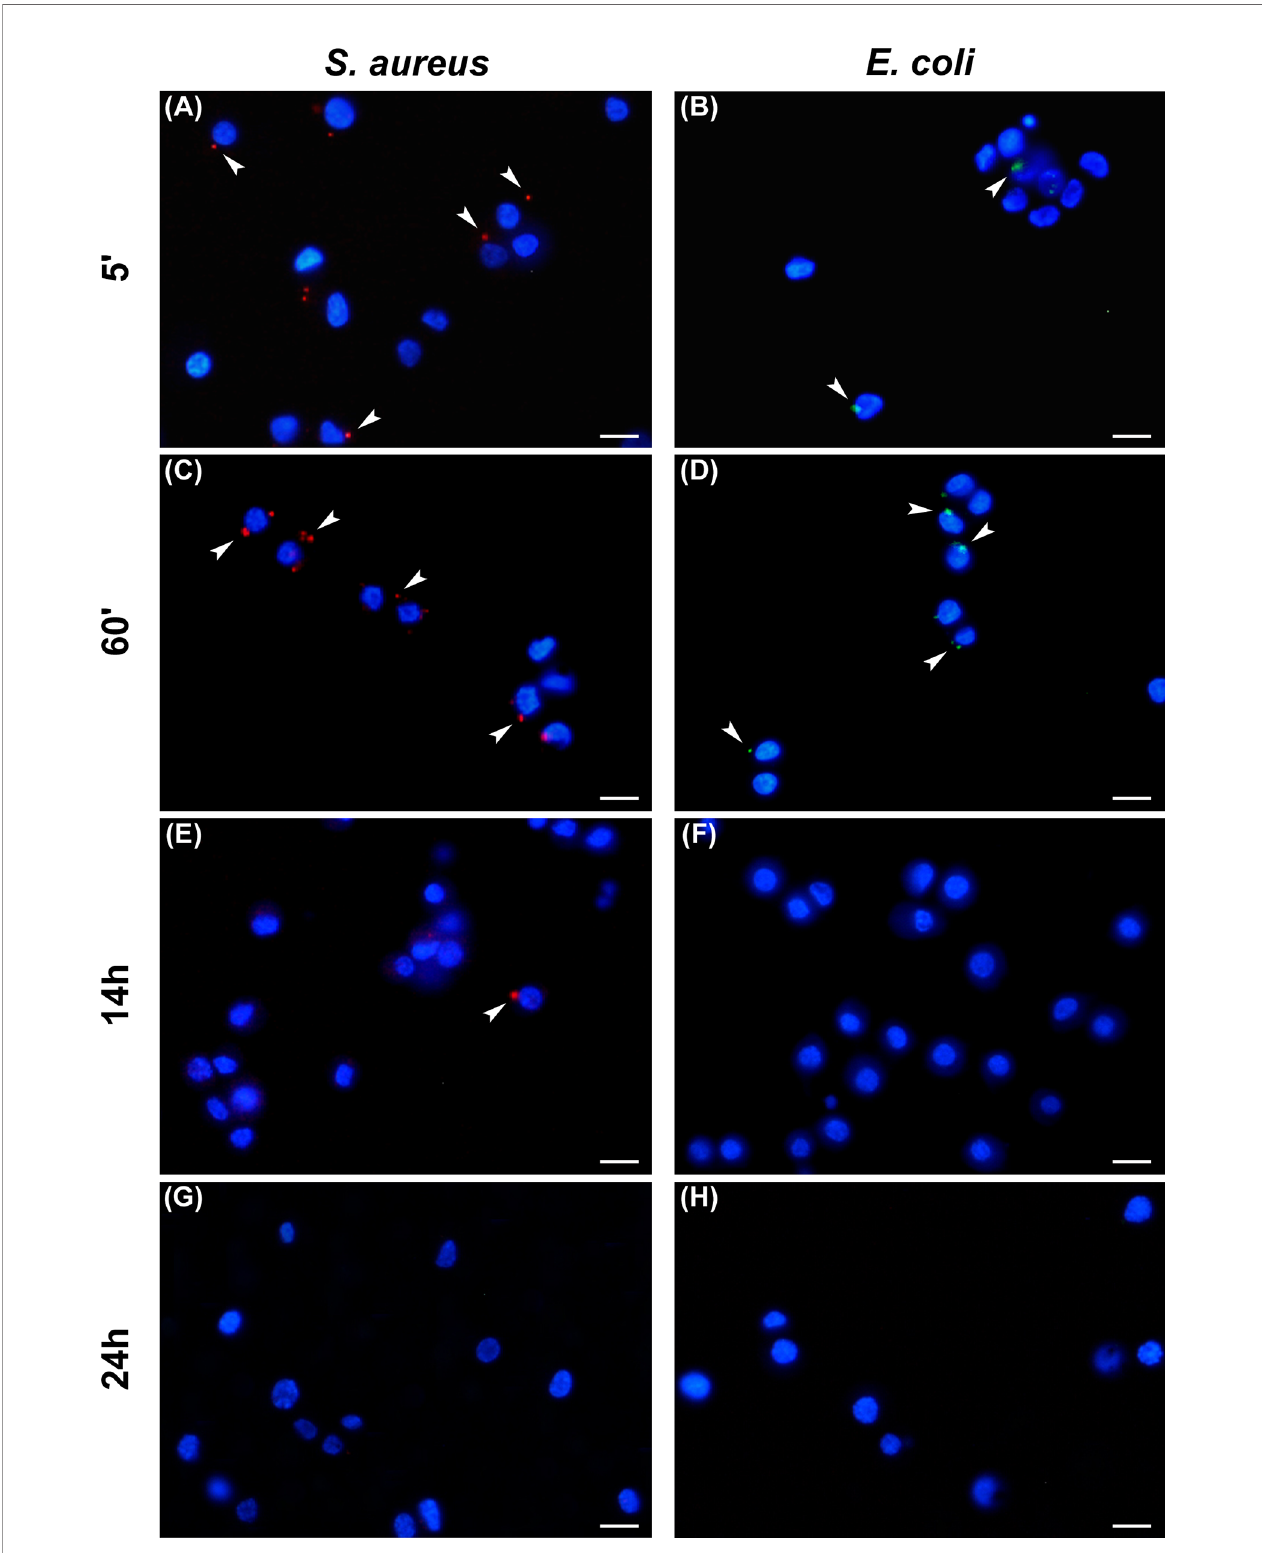
FIGURE 3 | Analysis of phagocytosis. Hemocytes undergoing phagocytosis 5 minutes (A, B) , 60 minutes (C, D) , 14 hours (E, F) , and 24 hours (G, H) after injection of Staphylococcus aureus (A, C, E, G) and Escherichia coli (B, D, F, H) conjugated with pHrodo. Arrows indicate phagocytosed bacteria. Bars: 10 µm.